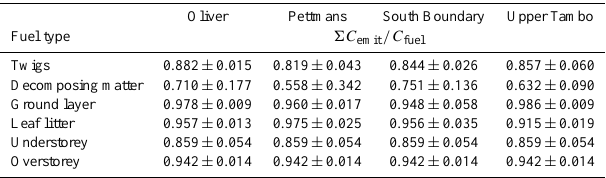
Table 3. Proportion of the fuel carbon burnt emitted into the atmo- sphere from different fuel types from forest sites in East Gippsland, south-eastern Australia. C emit is the total carbon emitted into the at- mosphere through combustion and C fuel is the initial carbon content of fuel. Coarse woody debris was assumed to have the same values as twigs. Values are mean ± standard deviation ( n =